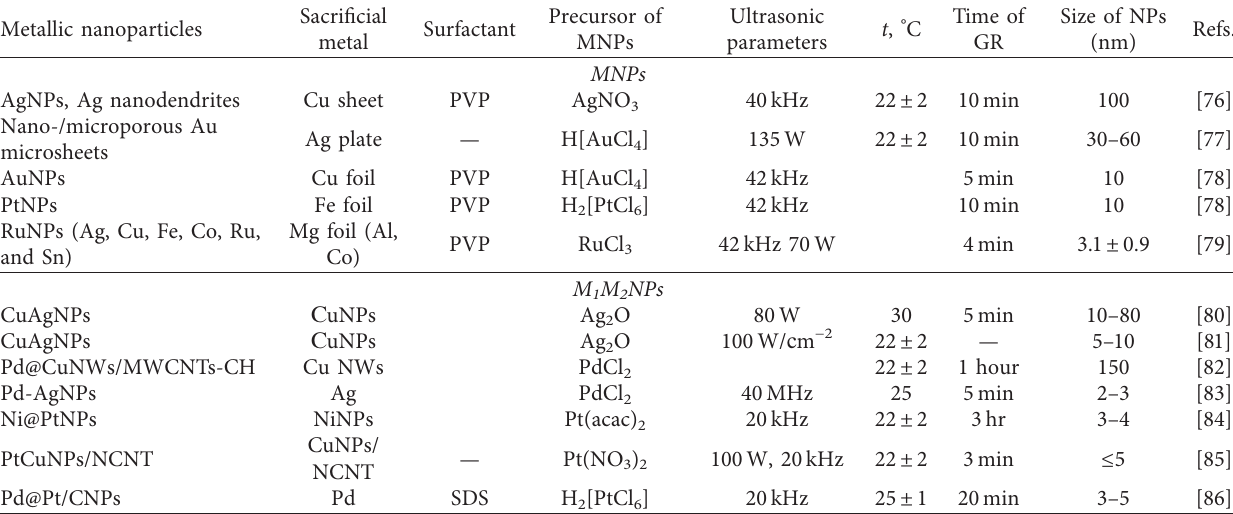
N 1 2 NPs) by galvanic replacement in an ultrasonic